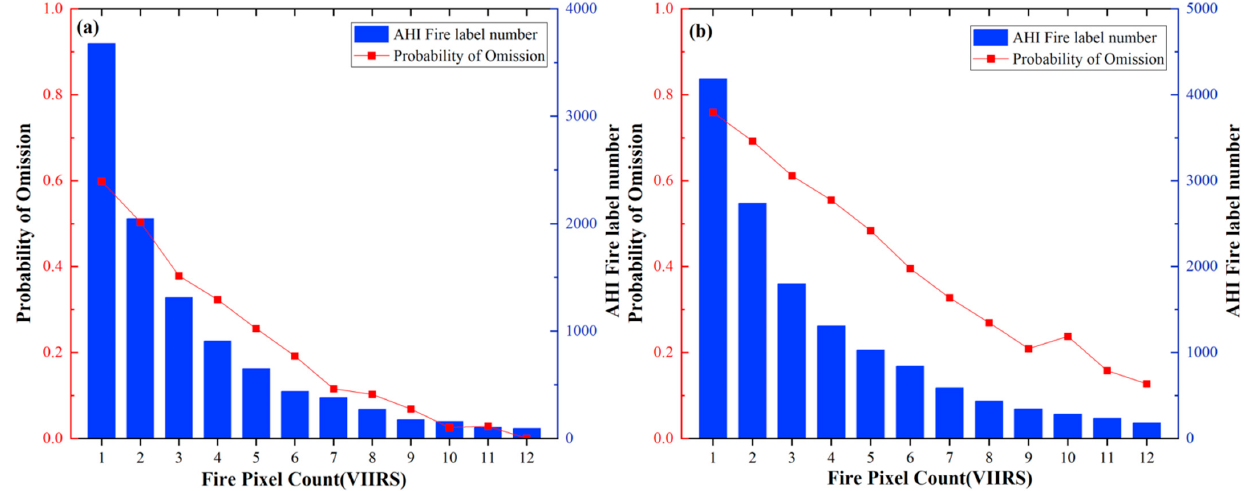
Figure 6. ( a , b ) show the probability of omission detections for the RF-D model and RF-N model, respectively, for Himawari-8 fire pixels containing different VIIRS fire pixel counts, and the histogram shows the total number of Himawari-8 fire pixels with different VIIRS fire pixel counts in the test dataset.